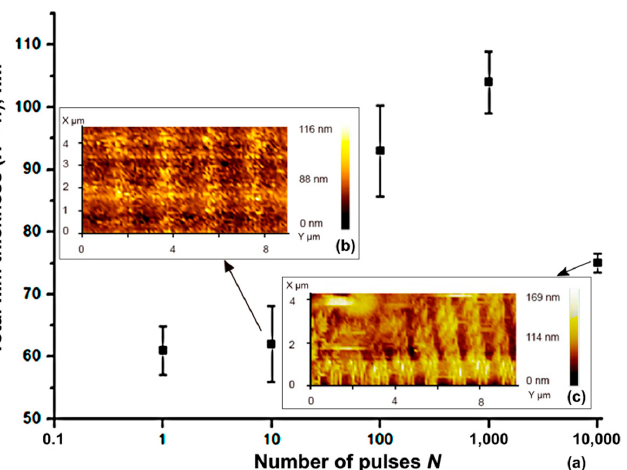
Figure 6. Figure 6. ( a ) Dependence of the total film thickness on the number of pulses N from 1 to 10,000. Insets ( b , c ) show the atomic force microscope (AFM) images of the structure surface after 10 and 10 4 pulses,